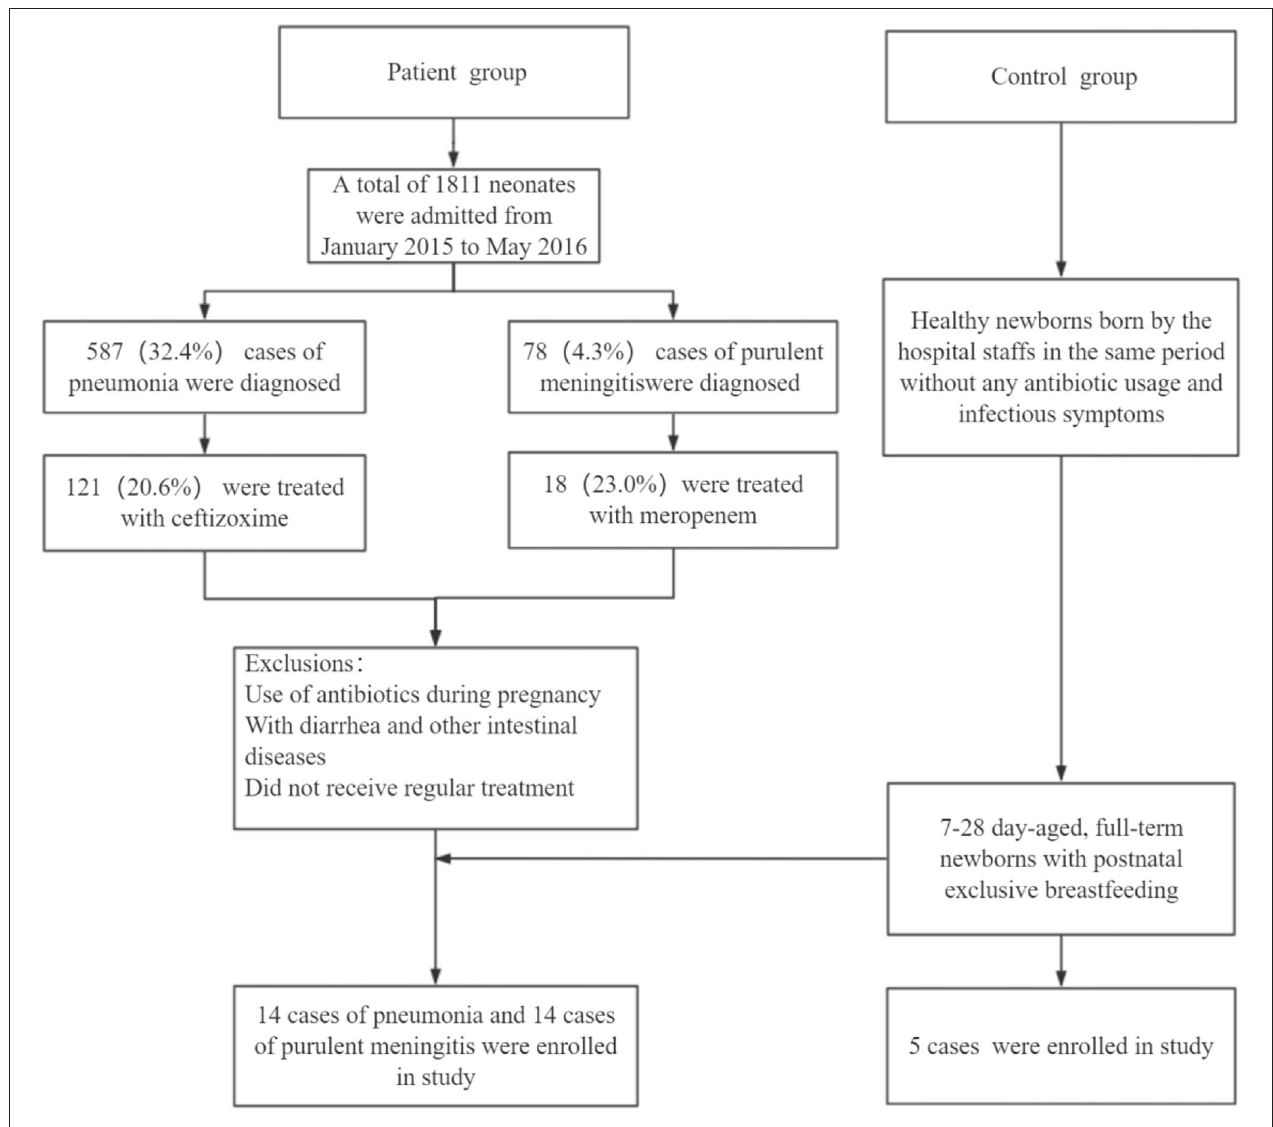
FIGURE 1 | Flow chart of neonate enrollment in our study.